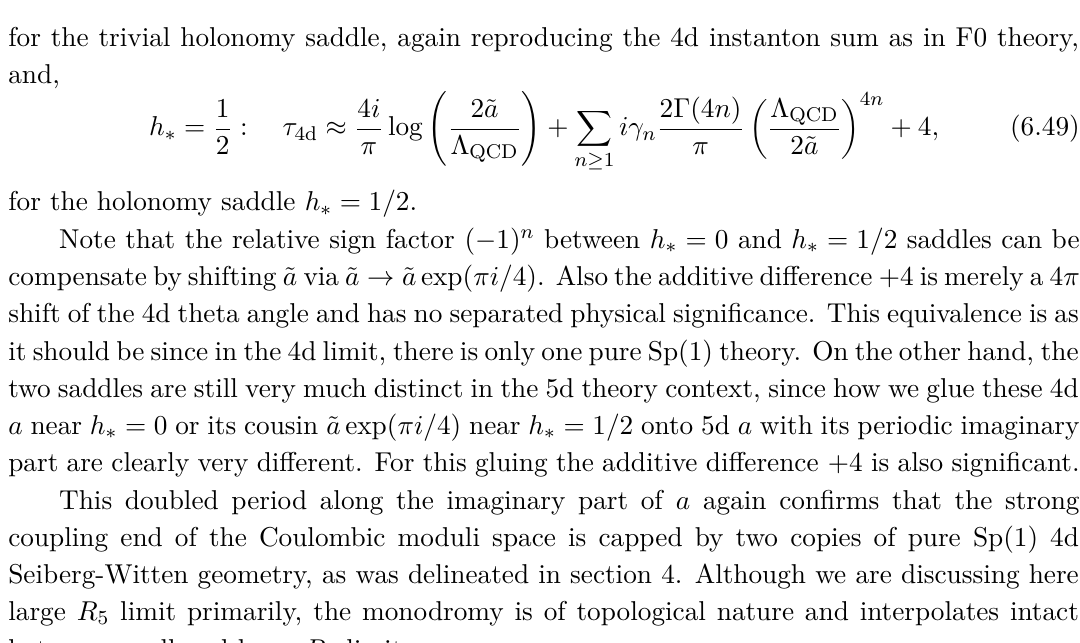
and collapse to a 5